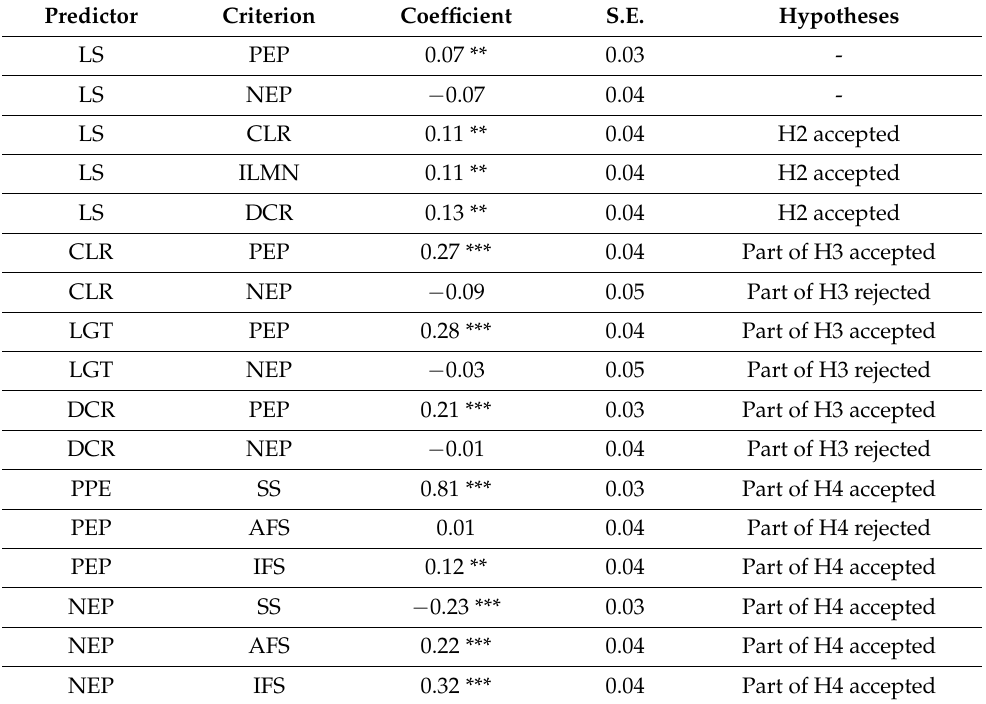
Table 3. Direct effects between